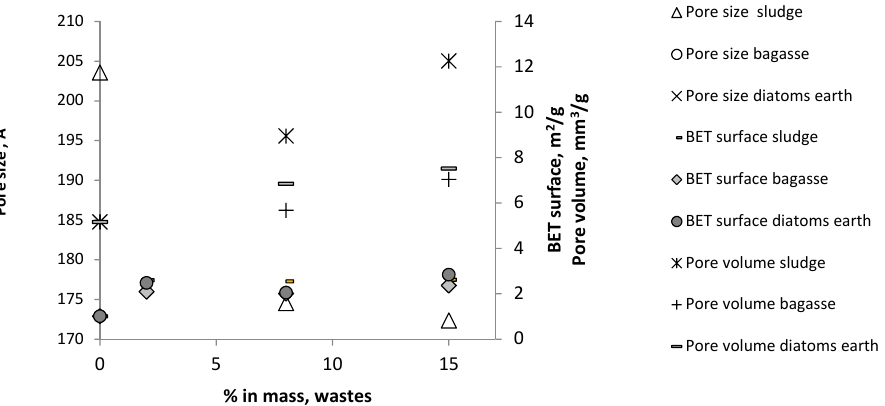
Figure 6. Size distribution and pore volume. Brunauer-Emmett-Teller surface, BET surface, 950 °C.